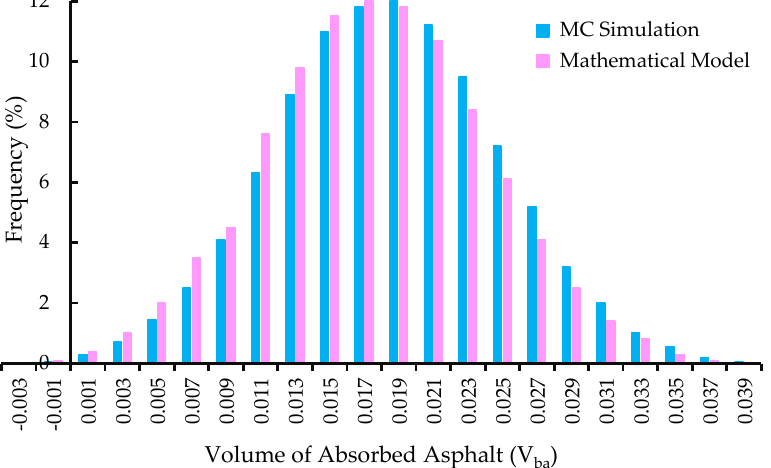
Figure 5. Comparison of uncertainty-based mathematical model and MC simulation